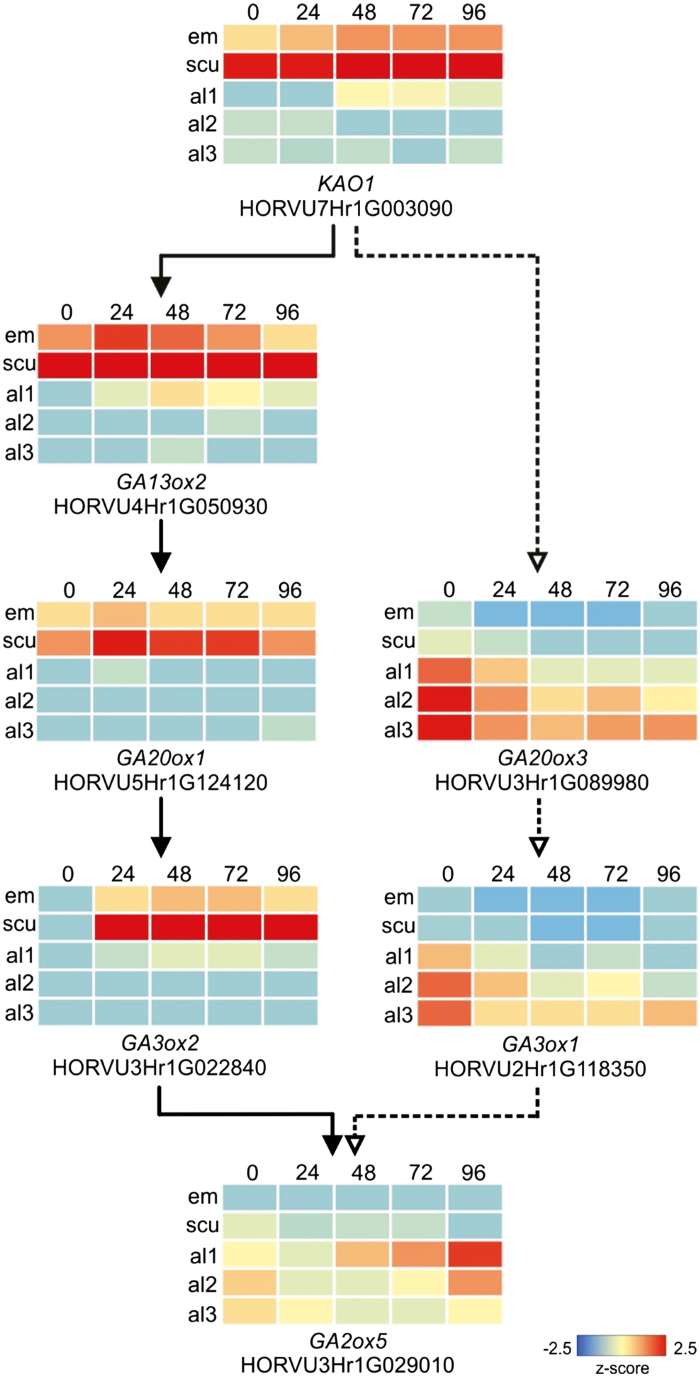
Expression levels of genes catalysing key steps of GA biosynthesis and catabolism. Embryo/scutellum (solid line path) or aleurone tissues (dotted line path) at 0, 24, 48, 72, and 96 h post-imbibition. Expression in transcripts per million (TPM) was converted to z-scores